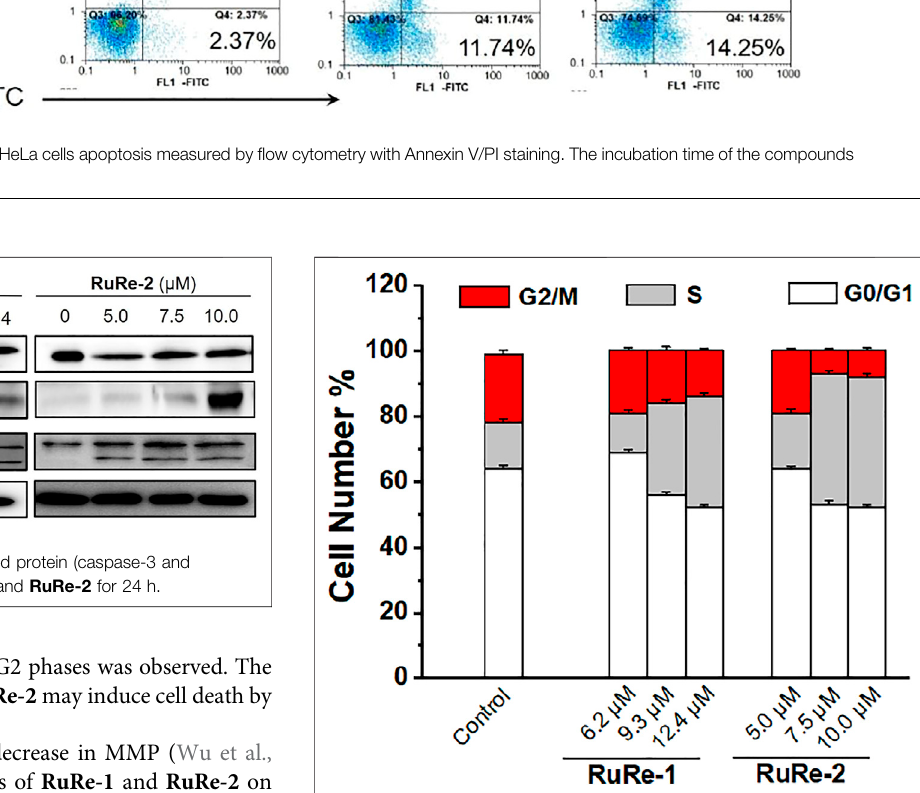
Frontiers in Chemistry |